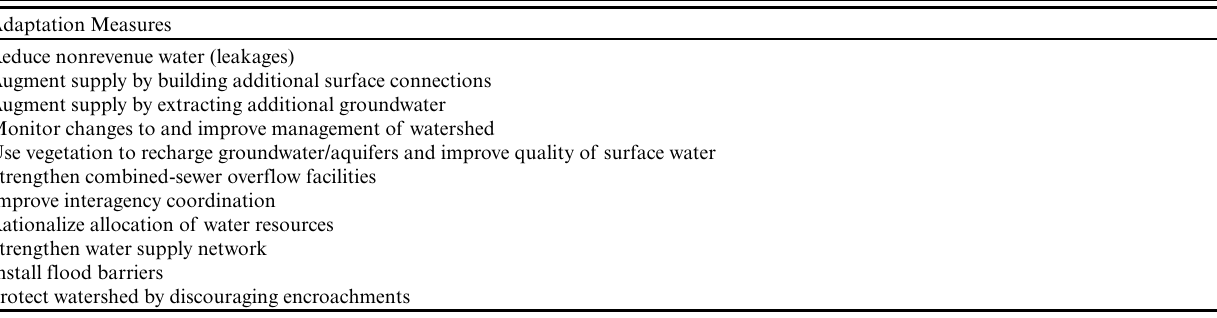
Table 6 . Adaptation measures implemented by Nairobi City Water and Sewerage